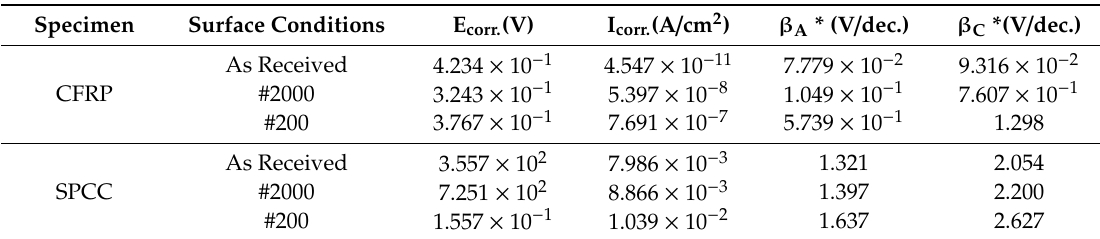
Table 2. Summary of potentiodynamic corrosion results for the CFRP and SPCC specimens with varying surface roughness.